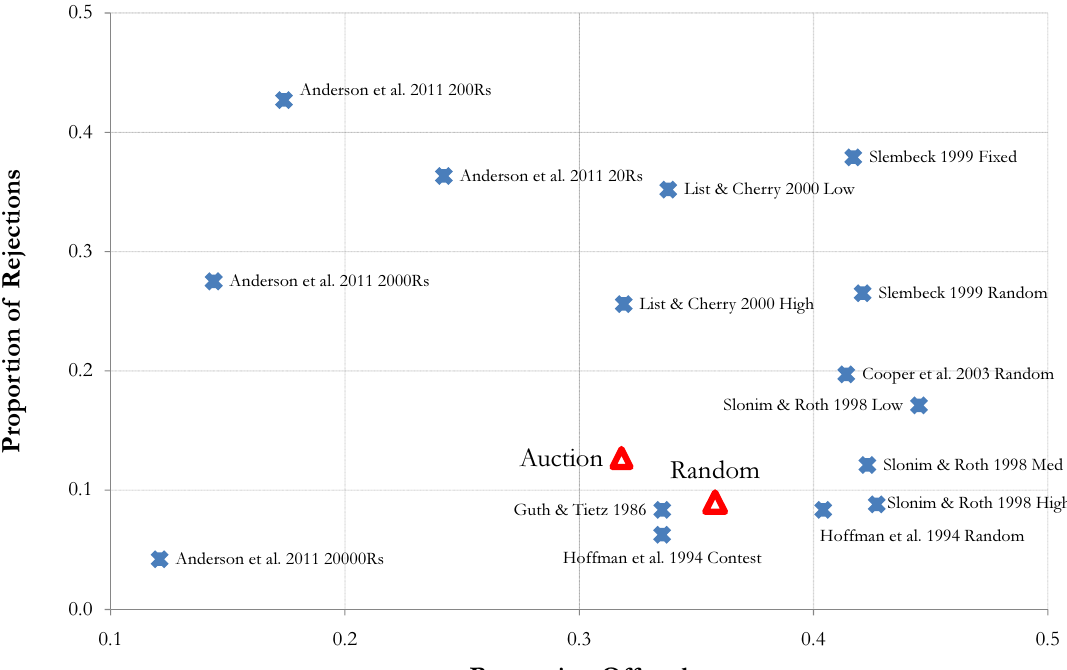
Figure 1. Proportions offered and rejection rates across studies and